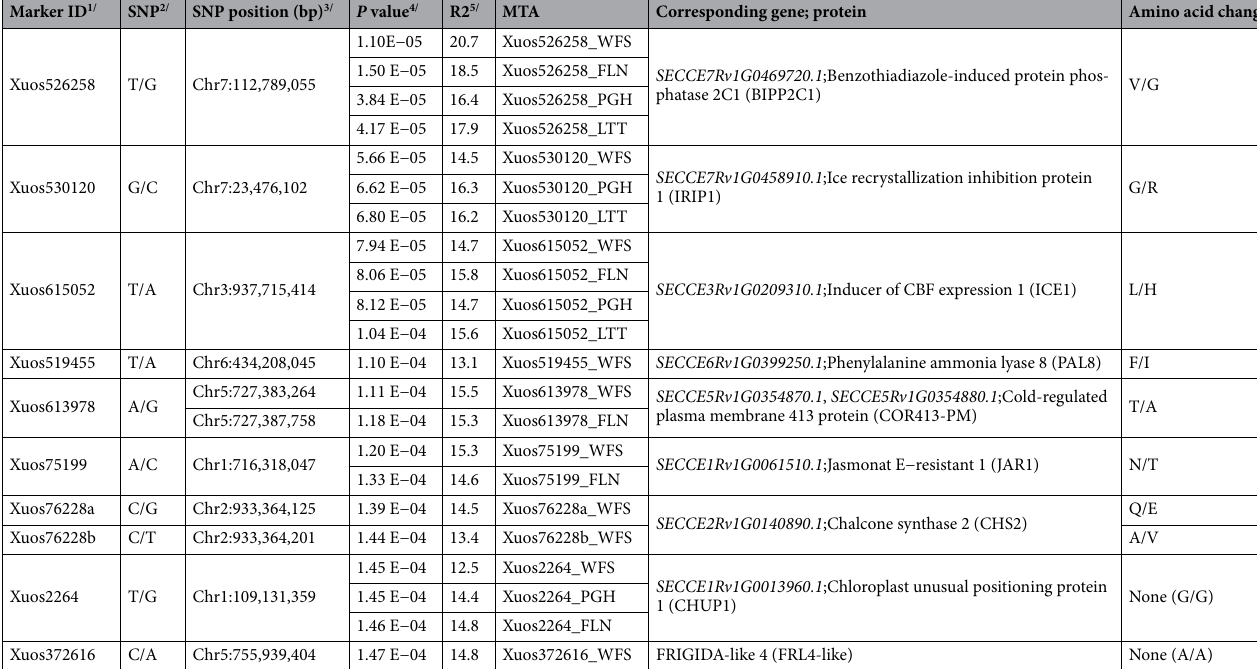
Table 2. Most significant MTAs identified in the study. 1/ Number refers to matching rye Lo7_v2_scaffold number 3 ; 2/ Reference/alternative allele; 3/ Position on rye Lo7 pseudomolecules version 1 assembly 4 ; 4/ Calculated upon Bonferroni correction. 5/ Explained